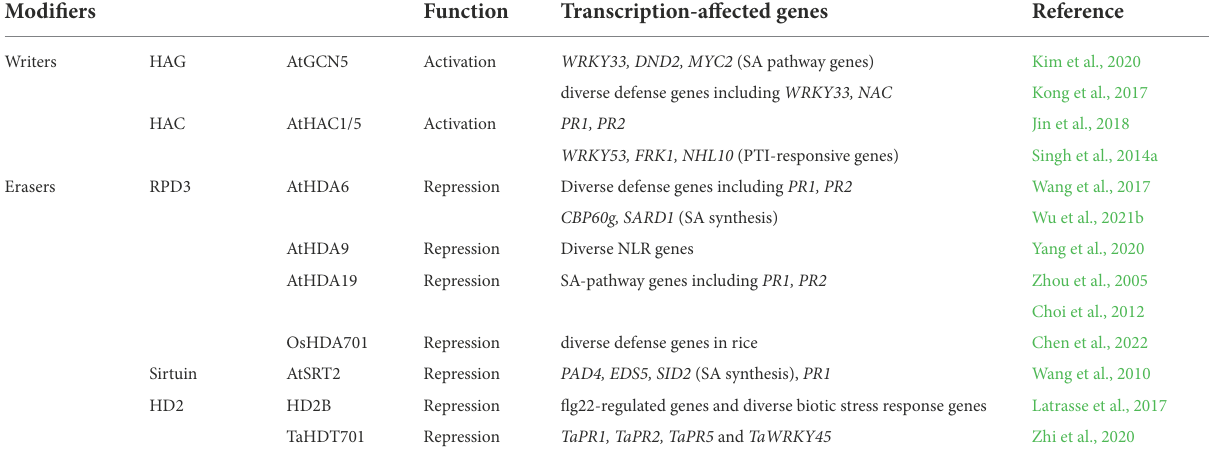
TABLE 2 Histone acetyltransferases and deacetylases implicated in plant response to